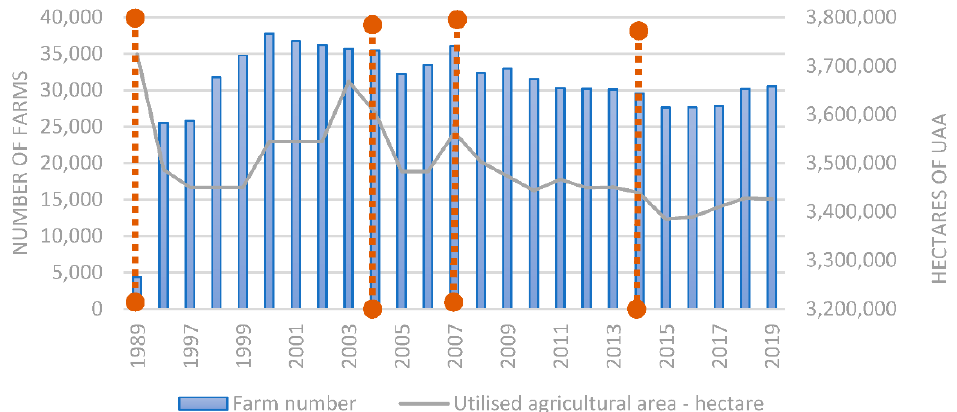
Figure 1. Farms number and utilised agriculture area in hectares in the Czech Republic after changes of agricultural subsidy rules (milestones are indicated by red doted lines). Source [15,16].